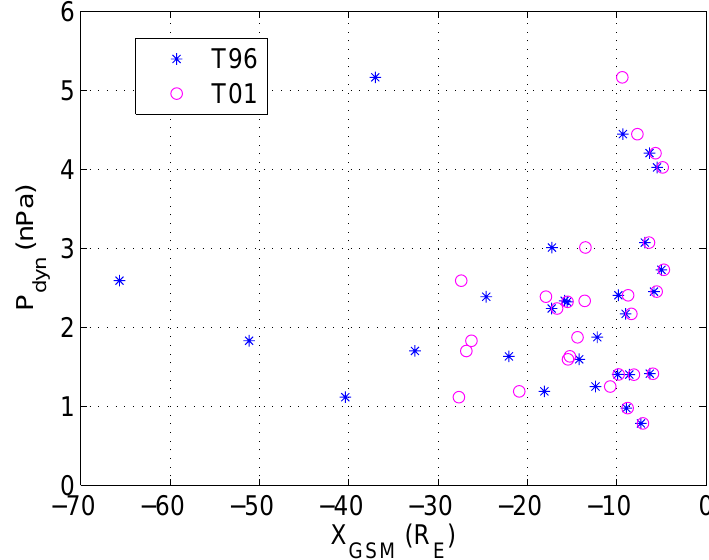
Fig. 8. Dependence of onset location with solar wind dynamic pressure.